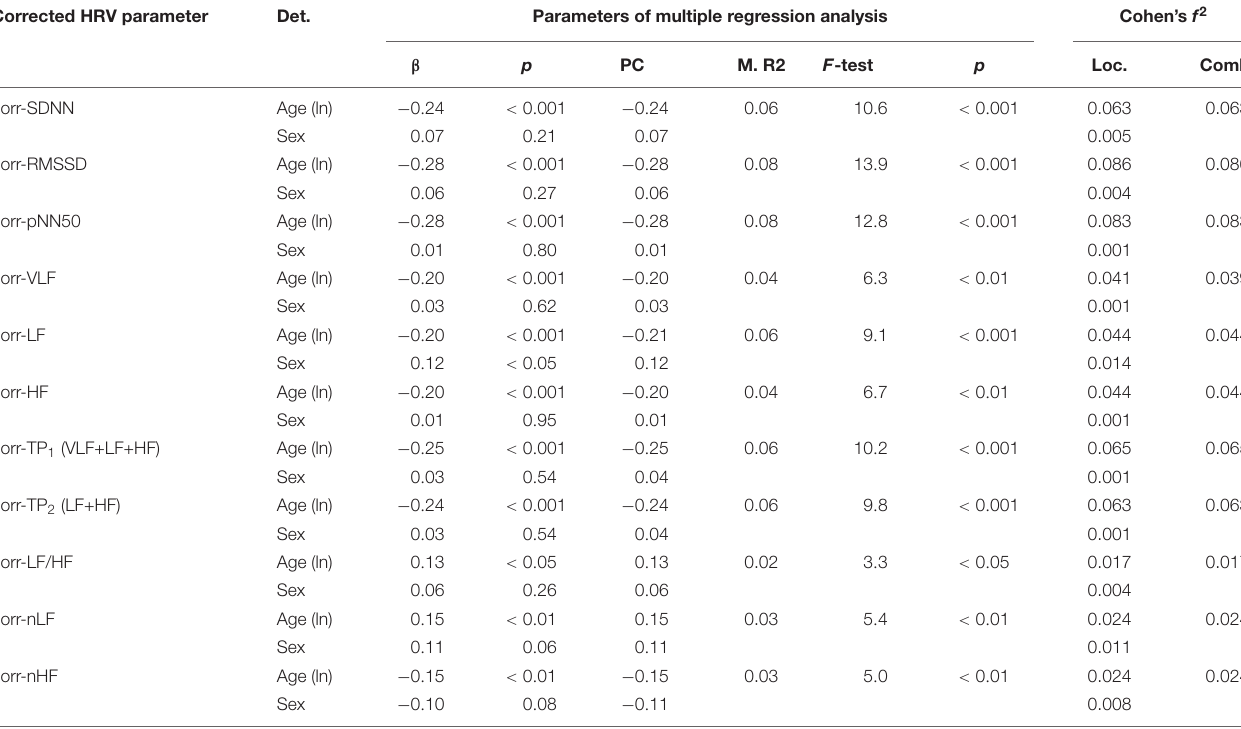
TABLE 4 | Determinants and Cohen’s f 2 indexes for corrected time- and frequency-domain (calculated with FFT) HRV parameters. Corrected HRV parameter Det. Parameters of multiple regression